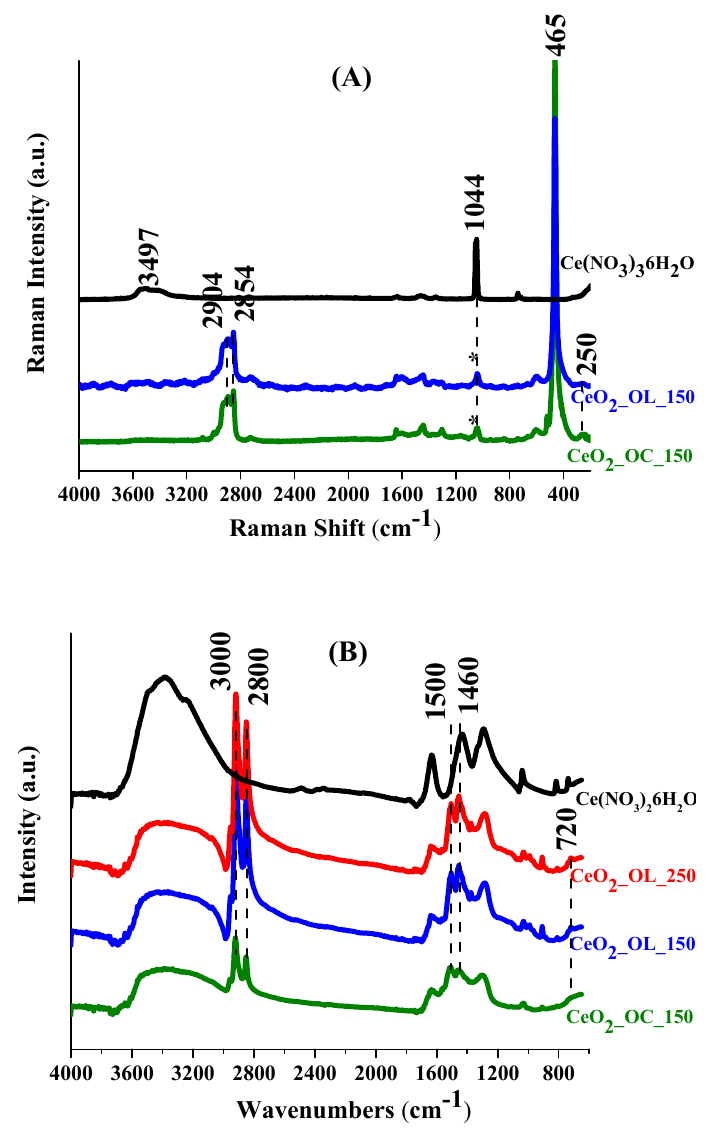
Figure 5. Vibrational characterization of CeO 2 nanoparticles. ( A ) Raman spectra of CeO 2 _OC_150 (green line), CeO 2 _OL_150 (blue line) and inorganic precursor (black line). ( B ) IR spectra of CeO 2 _OC_150 (green line), CeO 2 _OL_150 (blue line), CeO 2 _OL_250 (red line), and inorganic precursor (black line).